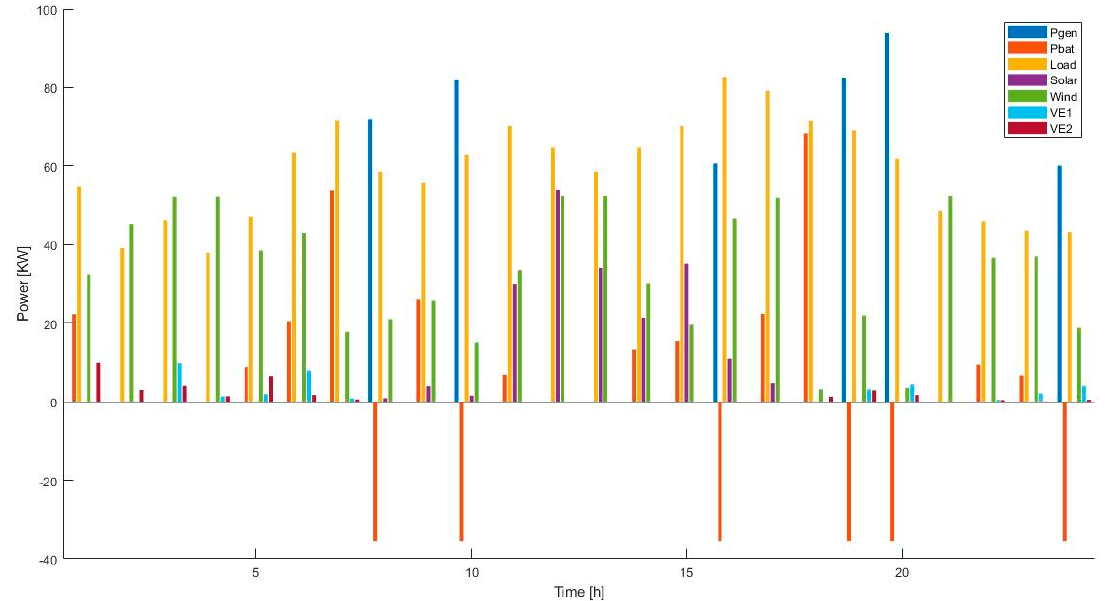
Figure 16. Availability and dispatch of the MG with the storage system at the end of its useful life.